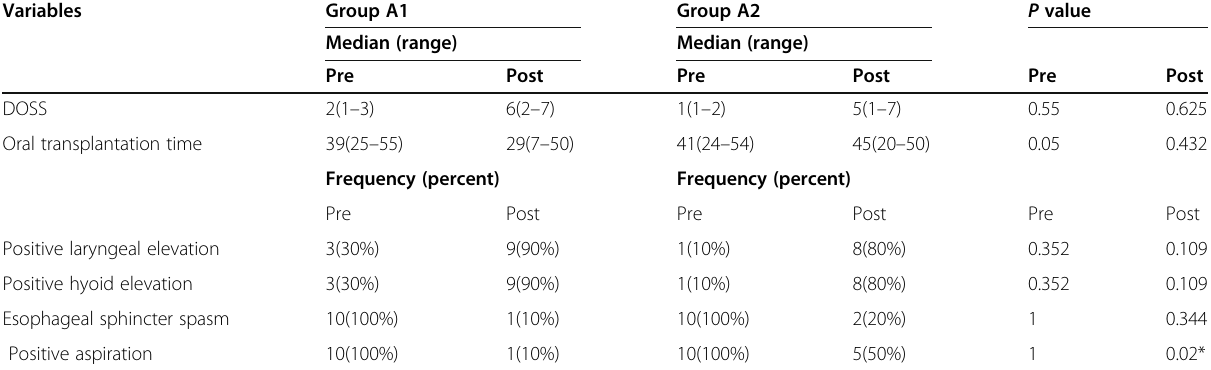
Table 6 Comparison the of DOSS score and different components of the digital fluoroscopic evaluation between pre- and post- treatment in groups A1 and A2